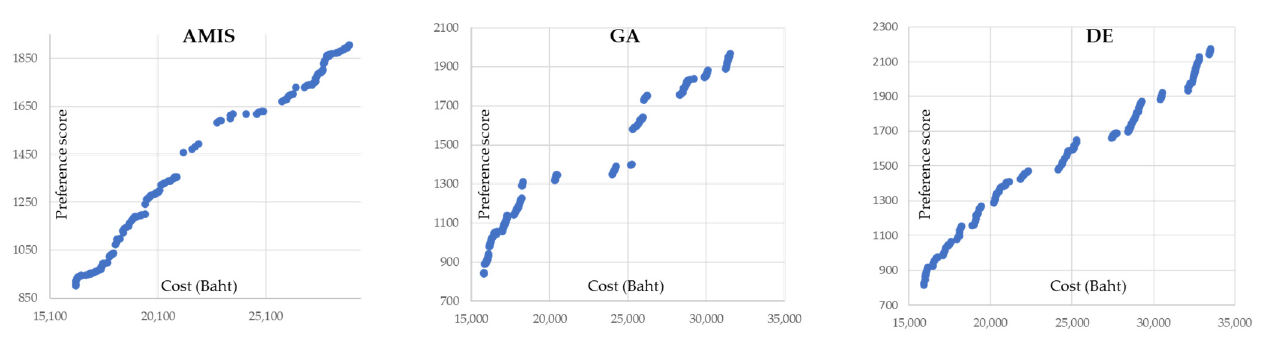
Figure 4. Pareto front of AMIS, GA and DE.